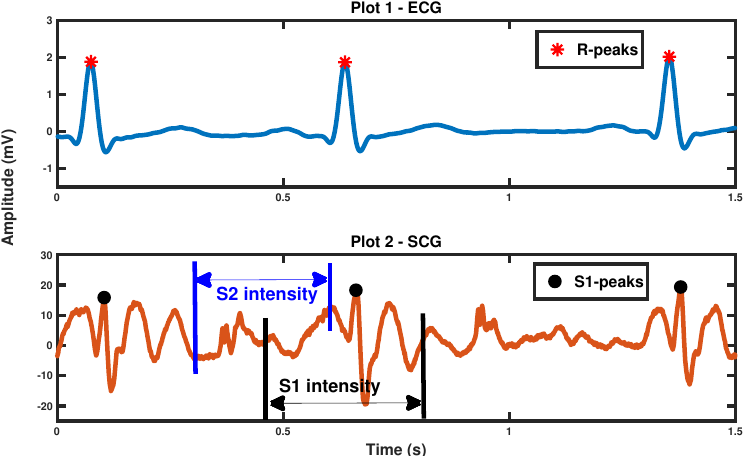
Figure 1. S1-peak identification on SCG: Plot 1 shows the ECG signal of subject b001, along with the detected R-peaks (red asterisks). Plot 2 shows the corresponding SCG signal, along with the identified S1-peaks (black circles). In addition, the time intervals for the S1- and S2-intensity are